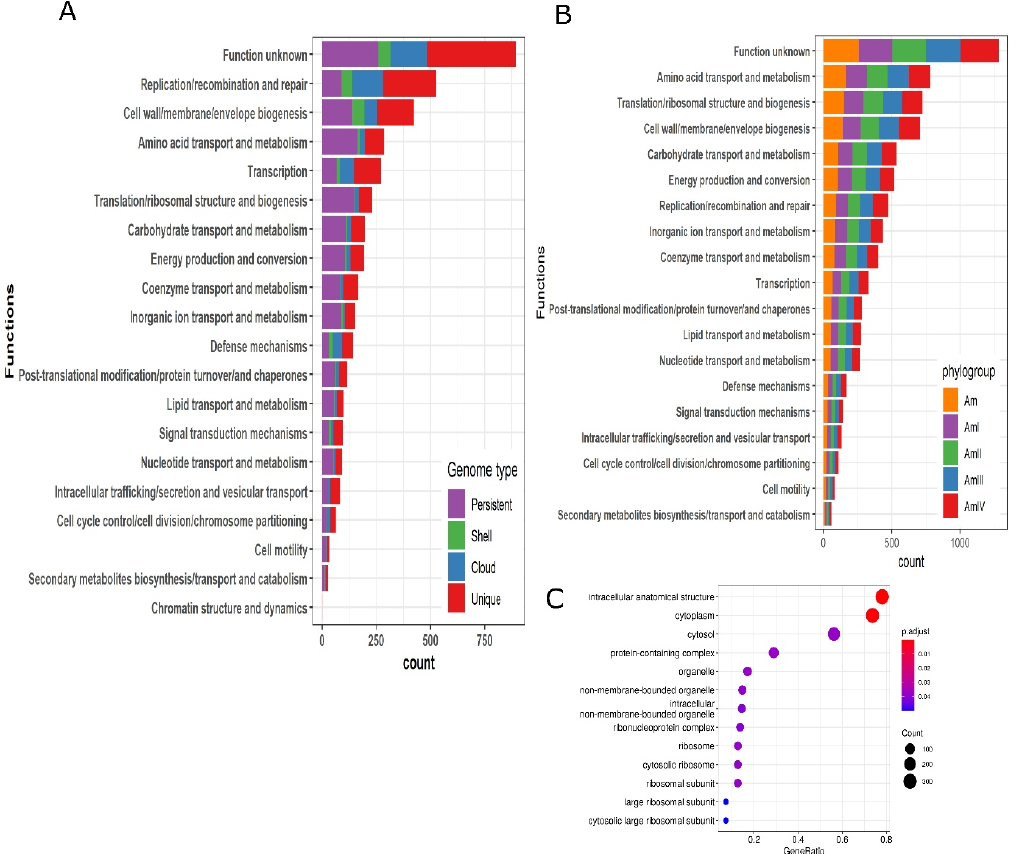
Figure 6. Clusters of orthologous (COG) annotation, enrichment analysis, and genomic islands. ( A